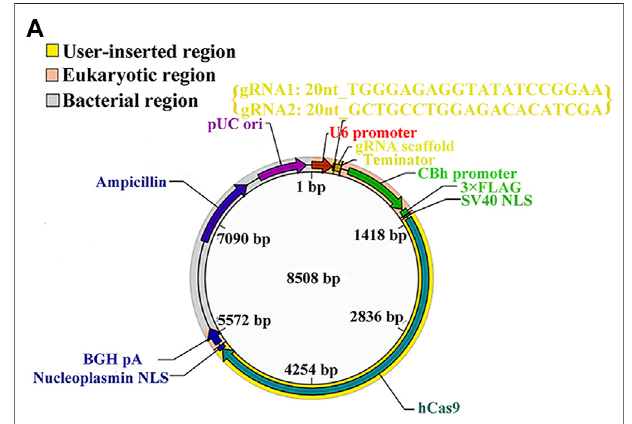
FIGURE 5 | (A) The vector map for miR-185-5p vector builder. U6 promoter: Human U6 promoter. {gRNA1: 20nt_TGGGAGAGGTATATCCGGAA; gRNA2: 20nt_GCTGCCTGGAGACACATCGA}:thecomponententered byuser. gRNA scaffold, Chimeric gRNA scaffold; Terminator, U6 terminator; CBh promoter, chicken beta act n hybrid promoter; 3xFLAG, three tandem fl ag epitopes; SV40 NLS, SV40 nuclear localization signal; hCas9, human codon- optimized Cas9; Nucleoplasmin NLS, nucleoplasmin nuclear localization signal;BGHpA,bovinegrowthhormonepolyadenylation;Ampicillin,ampicillin resistance gene; pUCori, pUC origin of replication. (B) Electrophoretic band chart for genotype detection. Green arrows represent WT rats, yellow represent KO, and blue arrow represents HET. The markers exhibit 100, 250, 500, 750, 1,000, and 2,000 bp, respectively. (C) The relative expression of Igfbp3 in the ratsof 185-WT and 185-KO. The relative expression wasrelative to that of the 185-WT in cortex group. (D) The glucose-uptake images in the brain and SUV max detected by PET-CT 2-month post HIE. (E,H) TTC staining and quantitative analysis of infarct ratio, respectively, in the rats of 185-WTand185-KO.Scalebar=1 cm.Palecolorrepresentsinfarctarea, n = 6/group. (F,I) HE staining and the cell size analysis of cortex and hippocampus, respectively, in the rats of 185-WT and 185-KO. Scale bar = 50 μ m, n = 6/group. (G) Nissl staining in cortex and hippocampus between 185-WT and 185-KO groups. The white arrow represents surviving neurons. The red arrow represents dark neurons. Scale bar = 100 μ m. (J,K) Quantitative histogram for total neuron and dark neuron in cortex and hippo in these groups, n = 6/group. (L,M) The time spent rearing and grooming in the open fi eld test 1 month after HIE, respectively, n = 6/group. (N) NSS score at 1 month after HIE. (O) The duration of on the rotarod bar 1 month after HIE, n = 6/group. (P) The latency to target for the fi rst 5 days training in the MWM test, n = 6/group. (Q) Target crossings in MWM test in the 6th day of testing. (R) The time spent in the initial, wrong and food arms of Y-maze at 1-month post HIE, n = 6/group. HET, heterozygote; 185-WT, miR-185-5p wild type; 185-KO, miR-185-5p knockout; PET-CT, positron emission tomography- computed tomography; SUV, standardized uptake value; HE, hematoxylin- eosin; Hippo, hippocampus. All data are presented as mean ± SD, * p < 0.05.